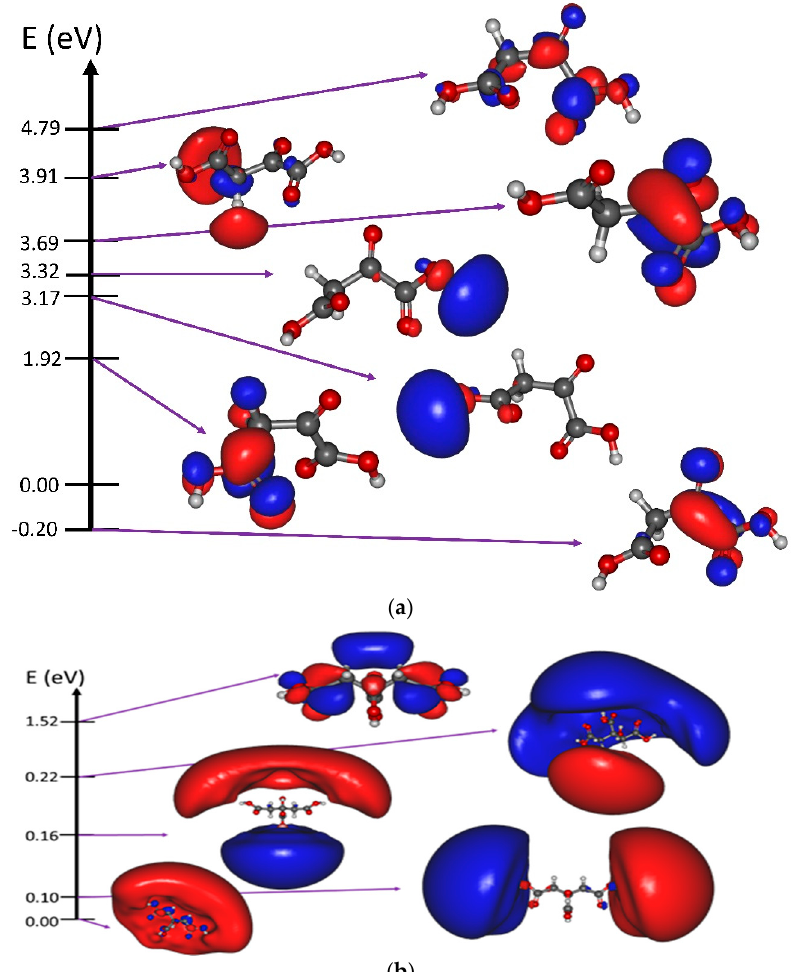
Figure 4. Calculated resonance energies (eV) and molecular orbitals associated to the attachment of the electron for ( a ) cis-enol oxaloacetic and ( b ) citric acids. Results obtained for the trans-enol OA are given in Figure S2. The cis-eno oxaloacetic acid was calculated at the ω B97x/cc-pvtz level at 0 K and citric acid at the ω B97x/aug-cc-pvtz level of theory at 0 K since the presence of diffuse orbitals.